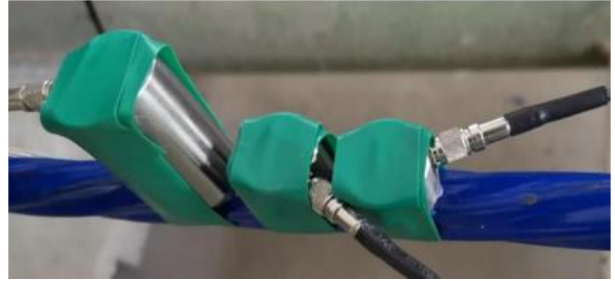
Figure 3. Acoustic emission sensors.